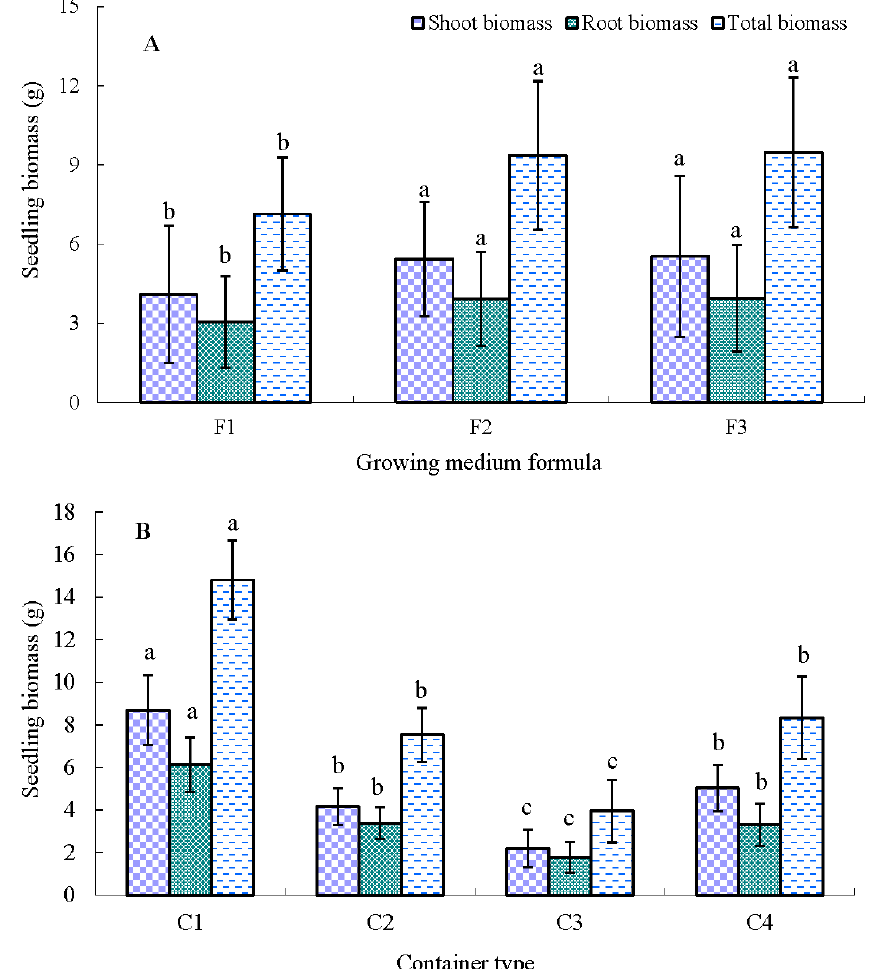
Figure 1. Effects of growth medium ( A ) and container type ( B ) on the biomass production of Cyclocarya paliurus seedlings sampled across the container types or growth media (means ± standard deviation). The means of the same biomass component followed by different letters are statistically different for container type or growth medium ( p < 0.05, LSD test).